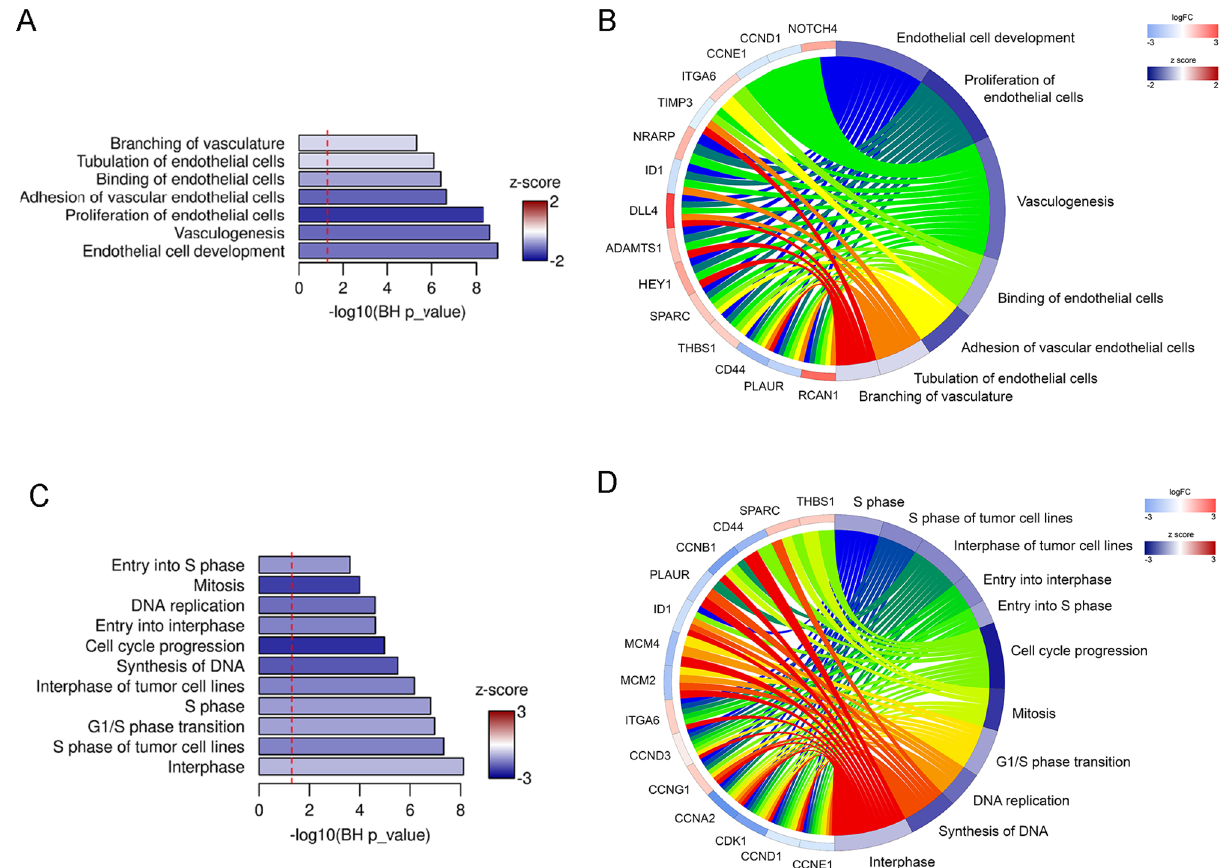
Figure 6. Ingenuity Pathway Analysis of differentially expressed genes in endothelial cells expressing ectopic miR-133a-3p. ( A , C ) Bar plots showing enriched biological functions predicted by IPA in the category “Cardiovascular system development and function” ( A ) and “Cell Cycle”, and “DNA replication, recombination and repair” ( C ). Bar lengths are relative to enrichment significance, expressed as − log10(Benjamini–Hochberg adjusted P values). ( B , D ) Circular plots representing enriched biological functions detected in the categories “Cardiovascular system development and function” ( B ) and “Cell Cycle”, “DNA replication, recombination and repair” ( D ). Enriched biological functions are connected to the associated differentially expressed genes. FC, fold change. Activation z-score scale: blue repression; red, activation. LogFC scale: red, upregulated; blue, downregulated. Barplots were generated with R 3.6.3 (https:// www.r- proje ct. org). Circular plots were generated with GOplot 1.0.2 (https:// wencke. github.